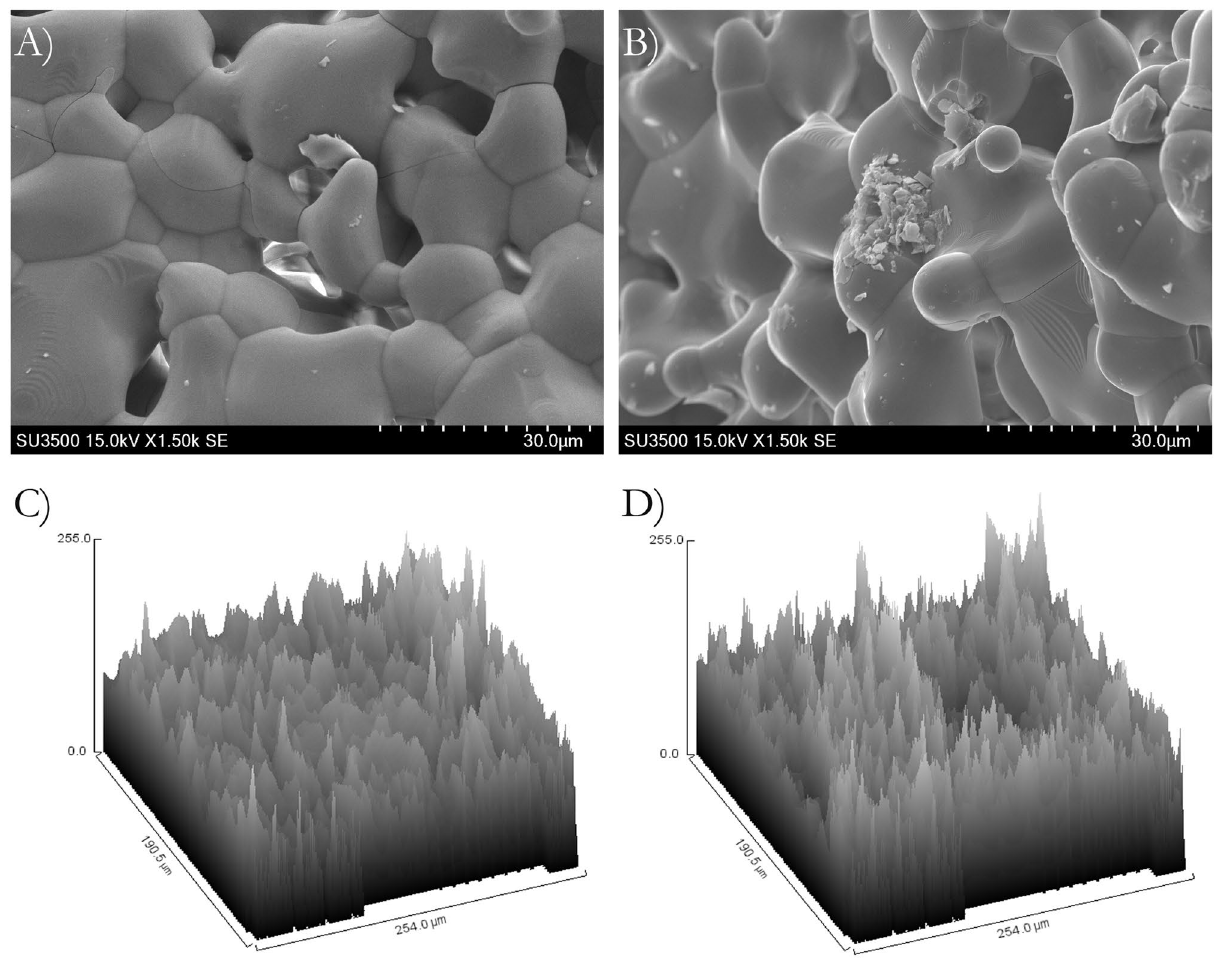
Figure 1. Scanning electron microscope (EX-250 SYSTEM, HORIBA, Kyoto, Japan) of β-TCP surface with ( A ) and without ( B ) GDP-treatment surface treatment, indicating similar surface. Topographic analysis of β-TCP surface with ( C ) and without ( D ) GDP-treatment surface treatment, showing R a slightly smother on GDP- treated β-TCP surface.